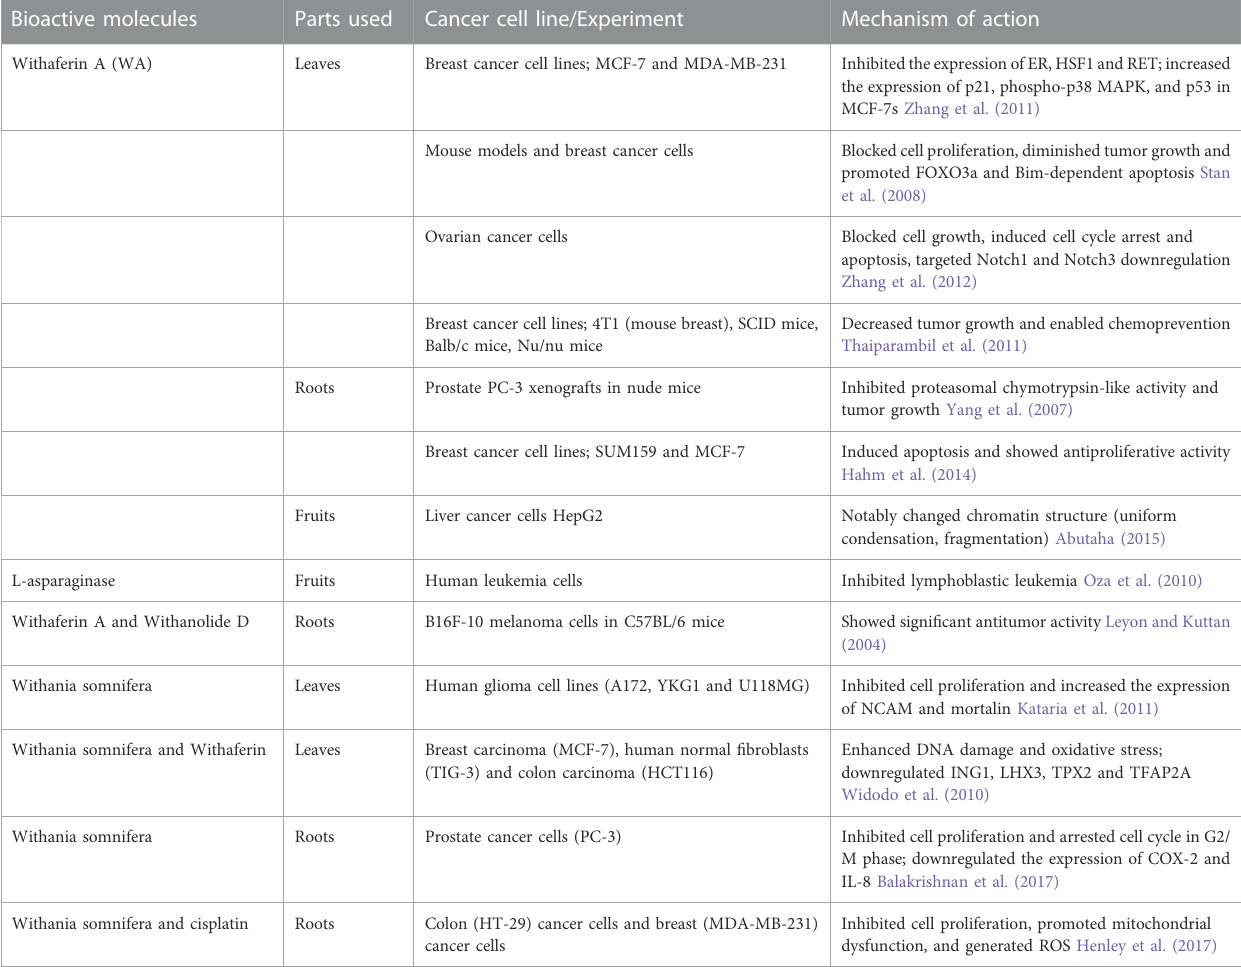
TABLE 1 Withania bioactive compounds, plant parts they are derived from, their target cancers, and their mechanisms of